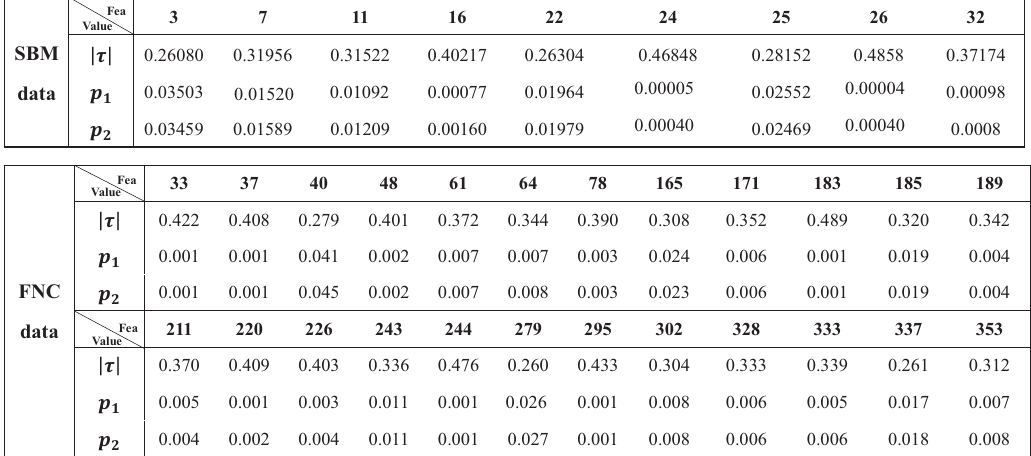
Figure 7. Feature selection results based on statistical